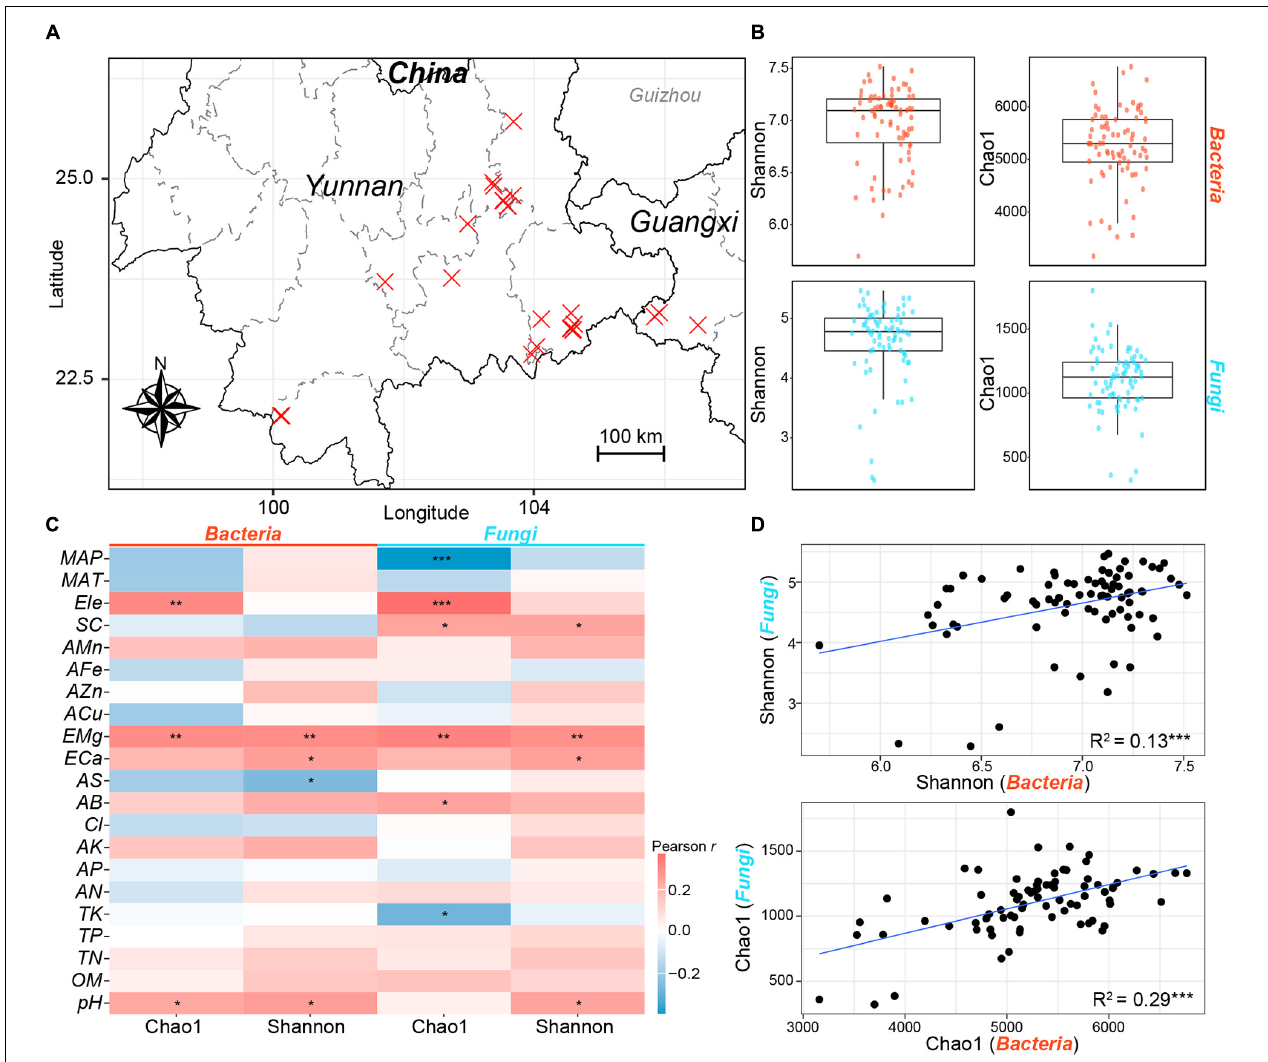
FIGURE 1 | Sampling map and α -diversities of rhizosphere bacterial and fungal communities. (A) The location of sampling sites. Each cross represents a sampling site. The x and y axes represent longitude and latitude, respectively. (B) The Shannon and Chao1 indices of bacterial (red) and fungal (blue) communities. (C) The Pearson correlation coefficients between α -diversity indices of bacterial and fungal communities and environmental variables. Red and blue cells represent positive and negative correlations, respectively. (D) The linear relationships between the α -diversity indices of bacterial and fungal communities. *, P < 0.05; **, P < 0.01; ***, P < 0.001. The abbreviations of variables accord to the section “MATERIALS AND